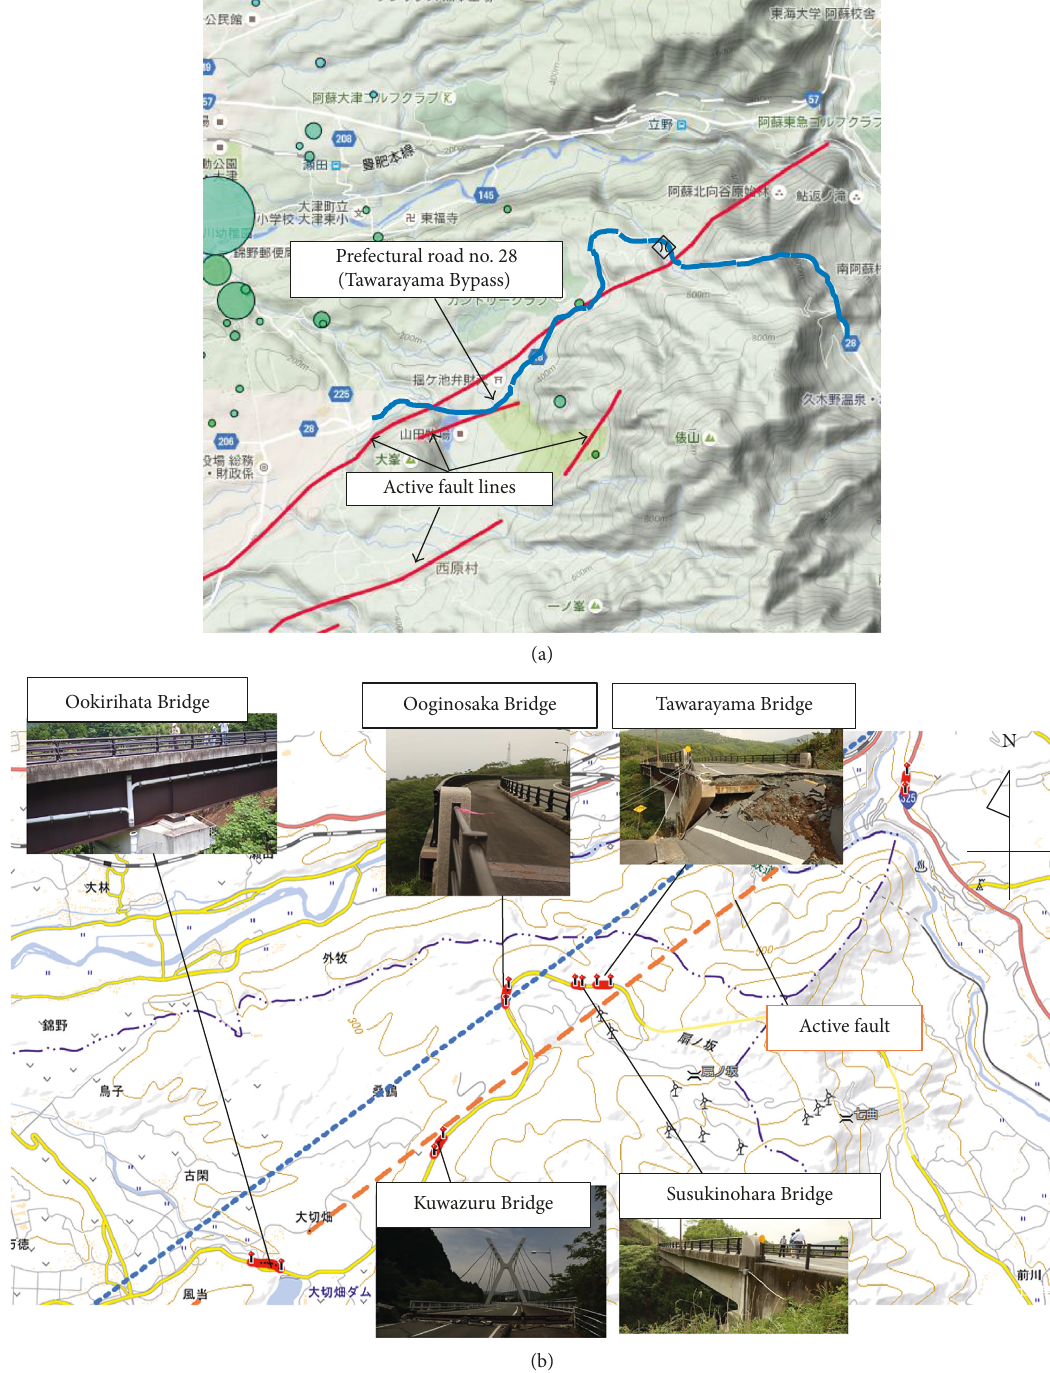
Figure 2: (a) Futagawa fault [4]. (b) Tawarayama Bypass and locations of